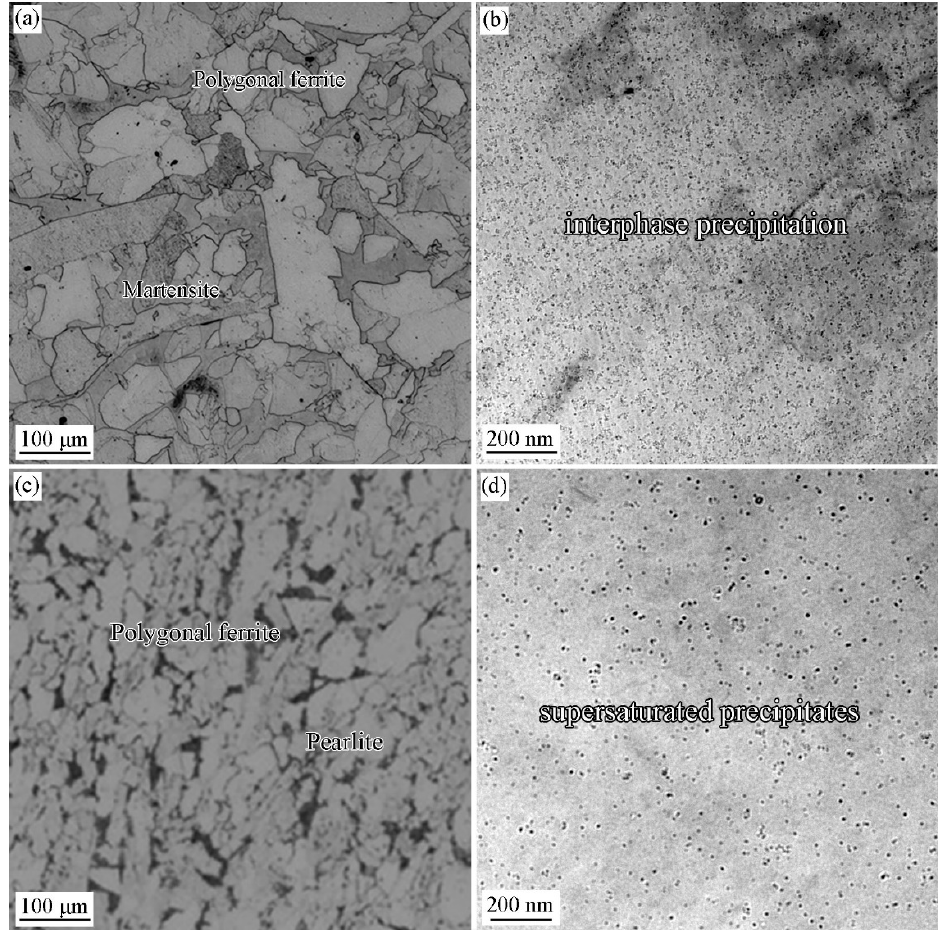
Figure 7. Optical microstructures ( a ) and TEM images ( b ) of Ti-Nb steel isothermally held at 660 °C for 20 min without austenite deformation; Optical microstructures ( c ) and TEM images ( d ) of Ti-Nb steel isothermally held at 660 °C for 20 min after austenite deformation.